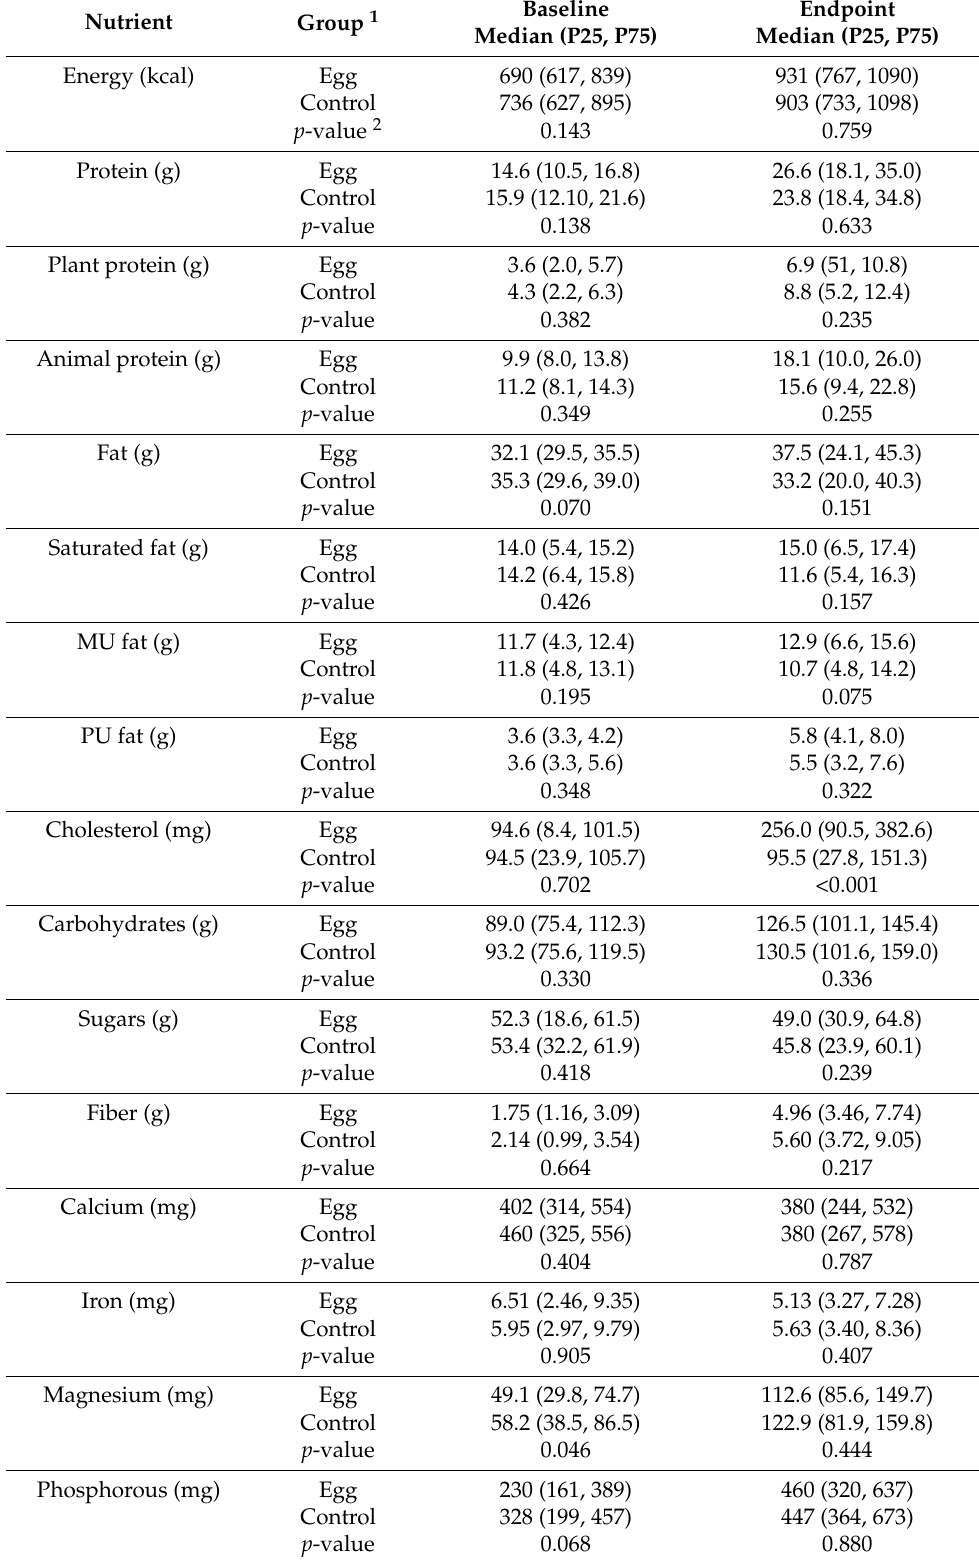
Table 2. Energy, macronutrient, and micronutrient intakes at baseline and